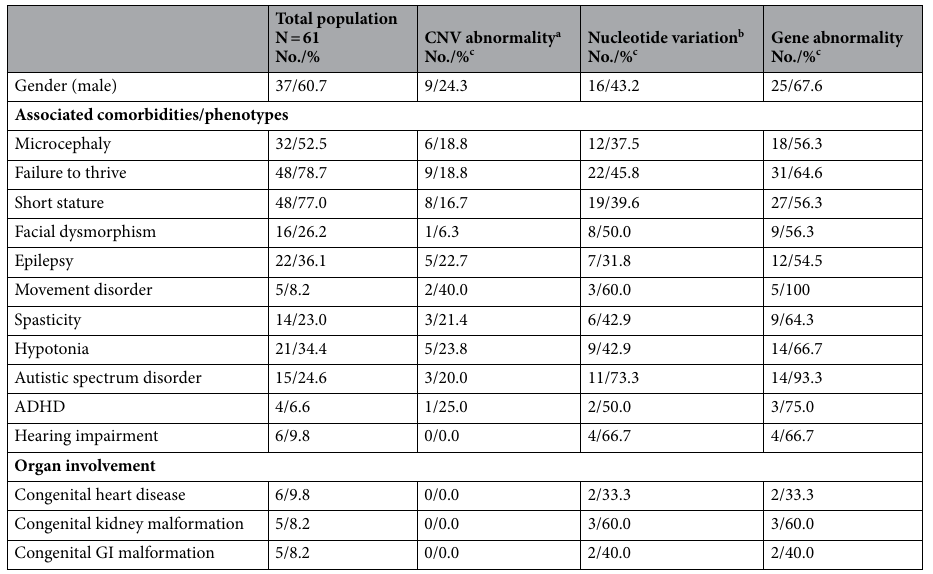
Table 1. Demographic data, associated phenotypes and genetic abnormality in study population. ADHD attention-deficit hyperactivity disorder, CNV copy-number variation. a CNV abnormality detected by chromosomal microarray. b nucleotide variation detected by whole-exome sequencing. c Denominator is the number of each items (in the second column of each